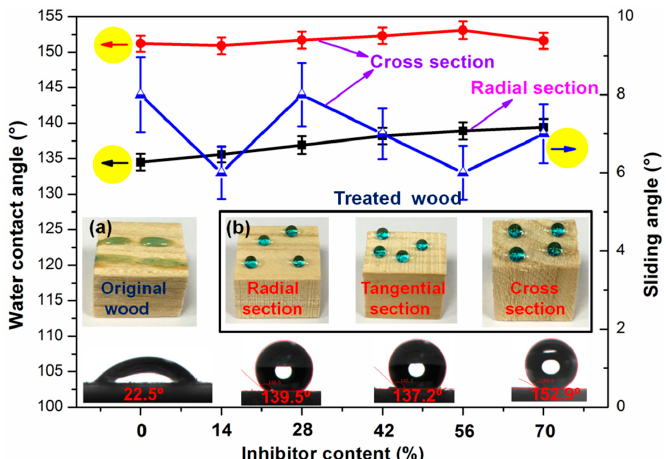
Figure 1. Water contact angle (WCA) and sliding angle (SA) on wood surface at different inhibitor contents. ( a , b ) Photographs of water droplets (dyed with methylene blue) on the original and modified wood (radial section, tangential section, and cross section). modified wood (radial section, tangential section, and cross